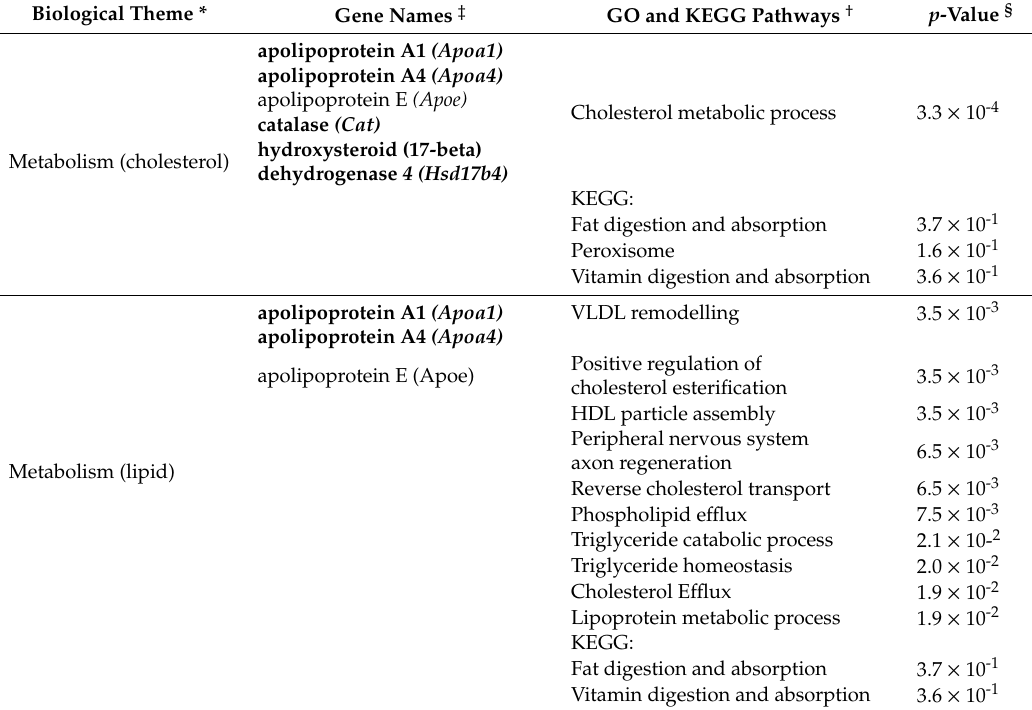
Figure 5. Cardiomyocyte area (mean ± SD) as a percentage of total area from left ventricular tissue in CON, HF and HF-FOS groups. Quantitation was done using ImageJ2. CON, control diet; HF, high-fat diet; HF-FOS, high-fat diet supplemented with fructooligosacchride; a : significantly di ff erent at p < 0.05; n = 7. Table 2. Enriched gene ontology (GO) terms and KEGG pathways in the list of di ff erentially expressed proteins in HF hearts compared to